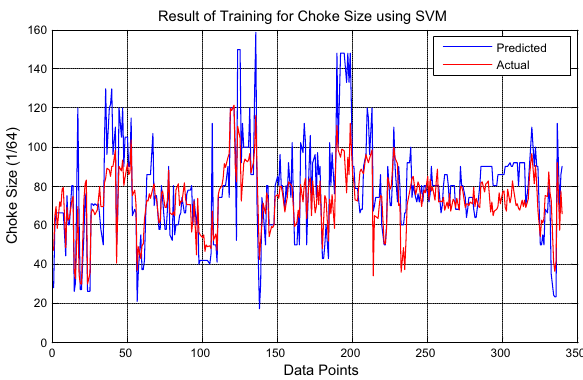
for trained and tested data of RBF model